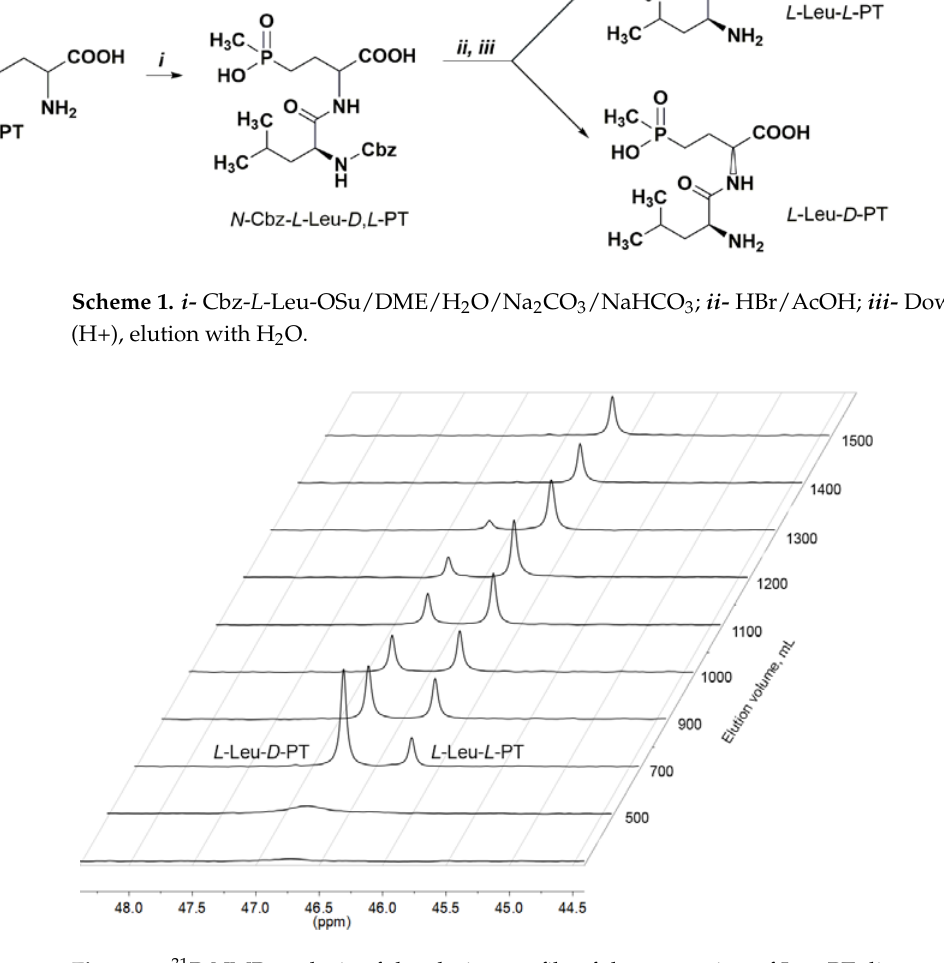
Figure 2. 31 P-NMR analysis of the elution profile of the separation of Leu-PT diastereomers on a Dowex-50WX8 column.